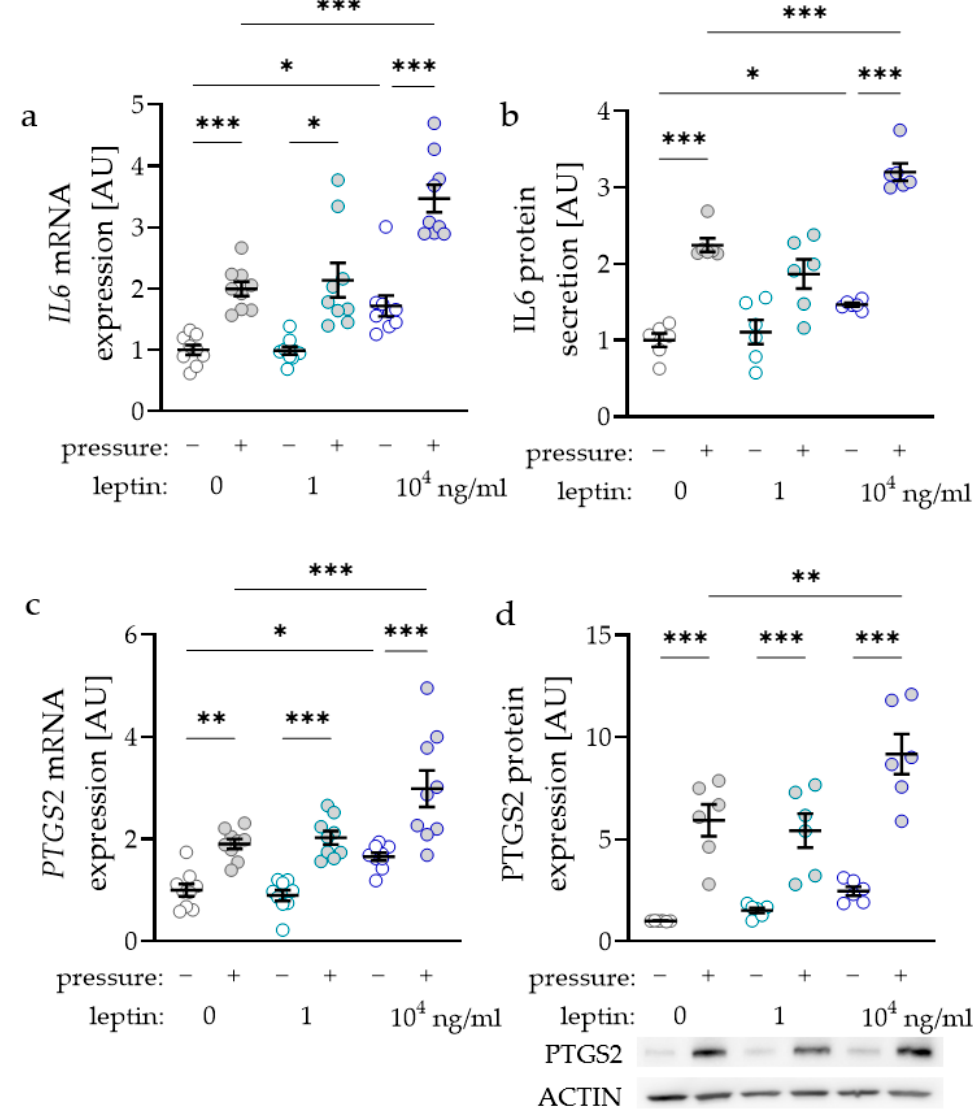
Figure 2. Impact of leptin in combination with compressive strain on gene and protein expression of interleukin-6 (IL6; a , b ) and prostaglandin-endoperoxide synthase-2 (PTGS2; c , d ) in PDLF; n ≥ 6; Statistics: ordinary ANOVA with Holm–Sidak’s multiple comparison tests (PTGS2) or Welch-corrected ANOVA with Games–Howell ´ s multiple comparison tests (IL6); * p < 0.05, ** p < 0.01, *** p < 0.001.